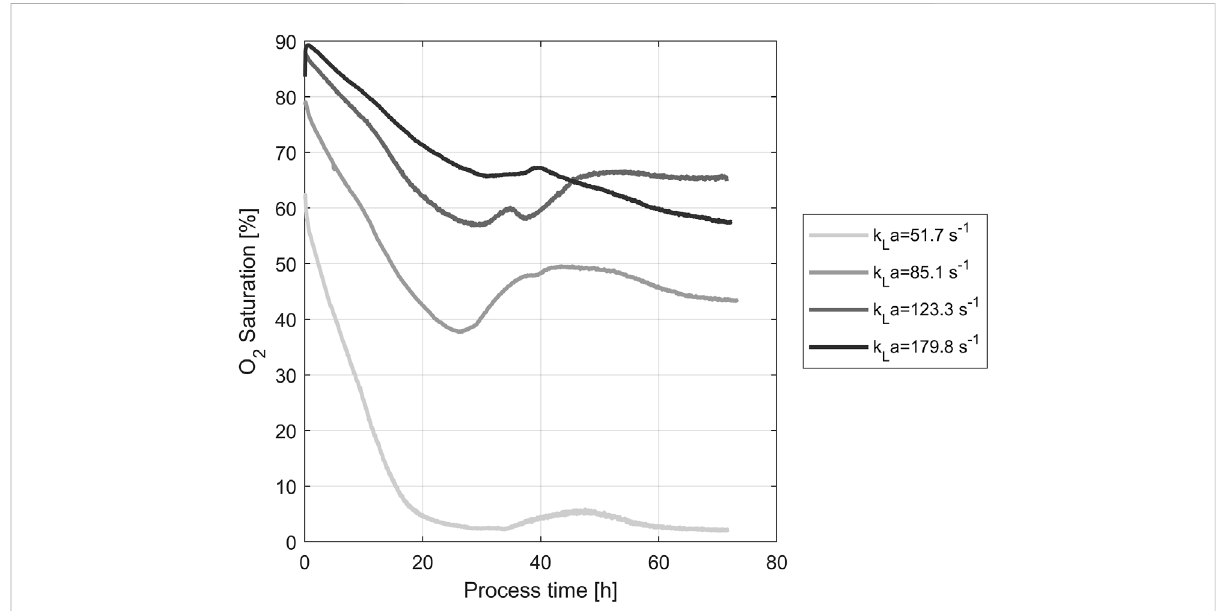
FIGURE 1 O 2 Saturations in themedium during yeast propagation. The different shaking speeds correspondto the following k L avalues: 100 rpm: 51.7 s − 1 , 150 rpm: 85.1 s − 1 , 200 rpm: 123.3 s − 1 , 250 rpm: 179.8 s − 1